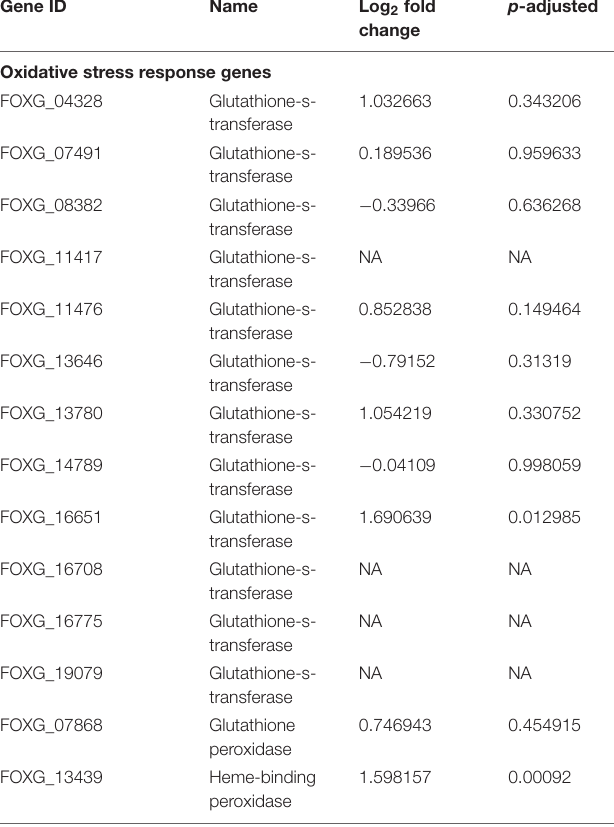
TABLE 1 | The effect of NA exposure on the expression of genes of the NAD + biosynthesis pathway and the response to oxidative